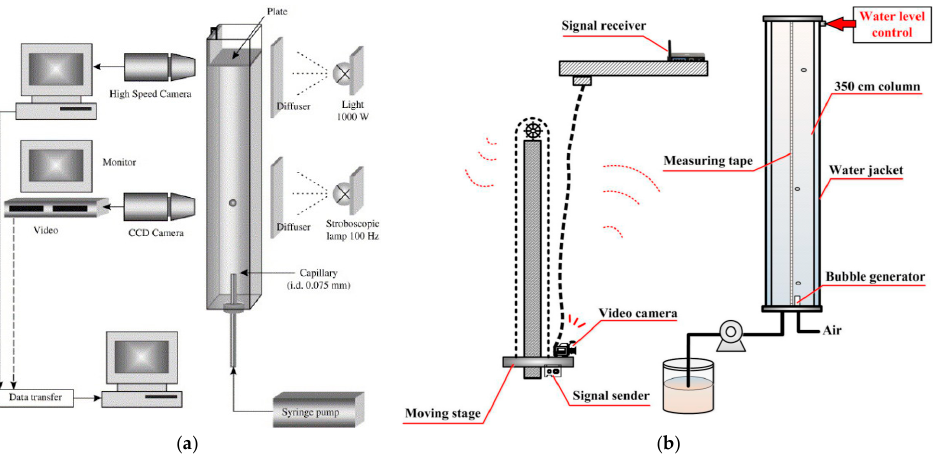
Figure 1. PAS ( a ) and McGill ( b ) experimental setups used to measure local velocity of the bubble (after [2,11]).